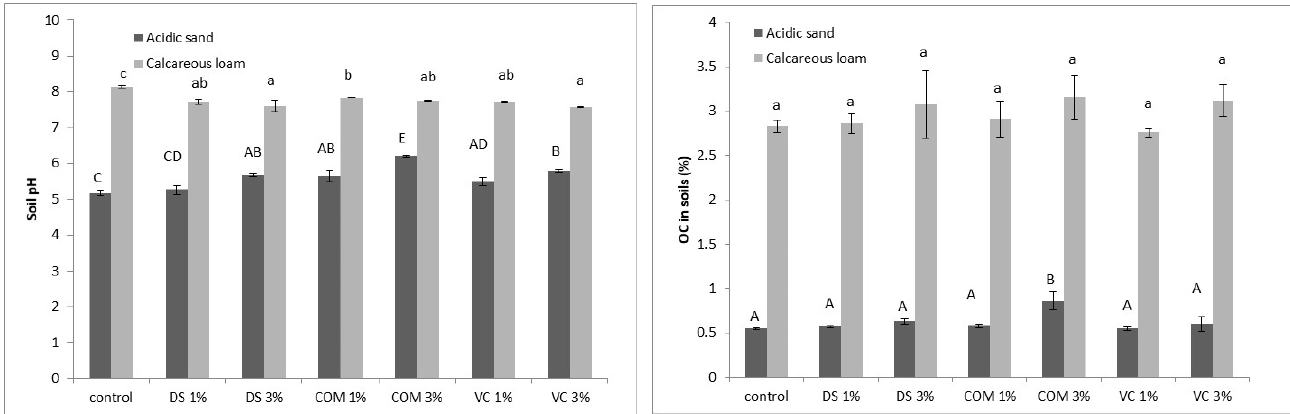
Figure 1. Changes in soil pH and organic carbon content (OC) 75 days after the application of digested sludge (DS), digested sludge compost (COM) and digested sludge vermicompost (VC) in 1% and 3% doses. Error bars represent the standard deviation (SD) of the mean with 3 replicates. Uppercase letters indicate significant differences between treatments on acidic sand and lowercase letters significant differences between treatments on calcareous loam ( p < 0.05).